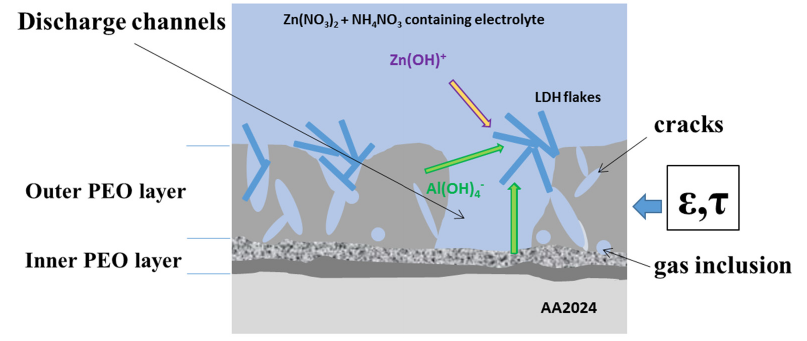
Figure 3. The schematic presentation of Al(OH) – 4 availability for the LDH growth.